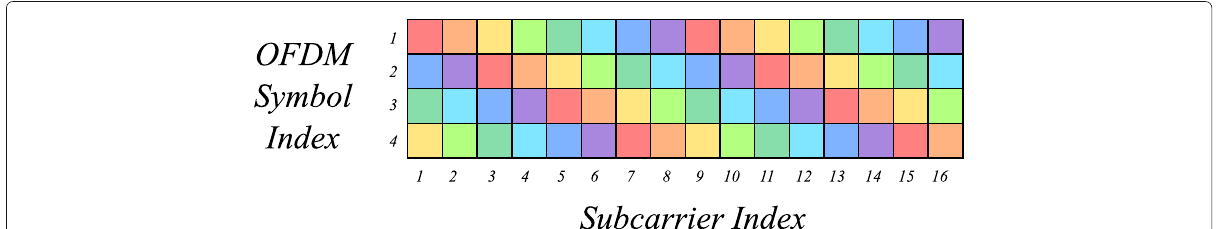
Fig. 3 An example of a repetition pattern for B = 4 OFDM symbols, N = 16 subcarriers, and M = 8 data-symbols